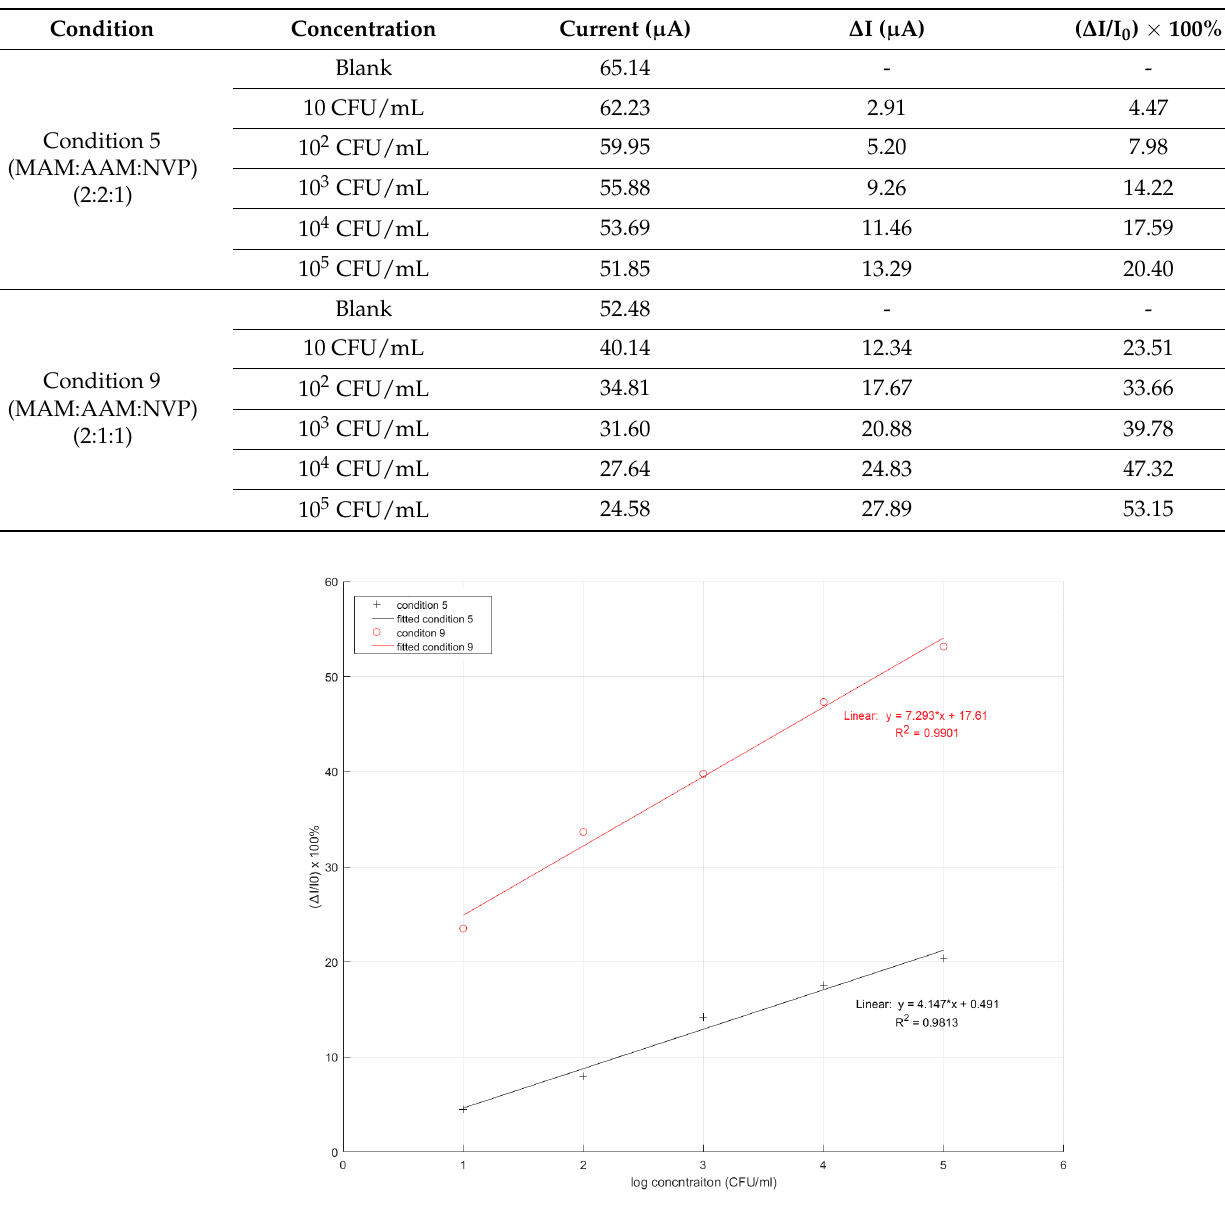
Figure 6. Comparison of linearity range for condition 5 and condition 9 on the gold electrode (* is referred to multiplication).